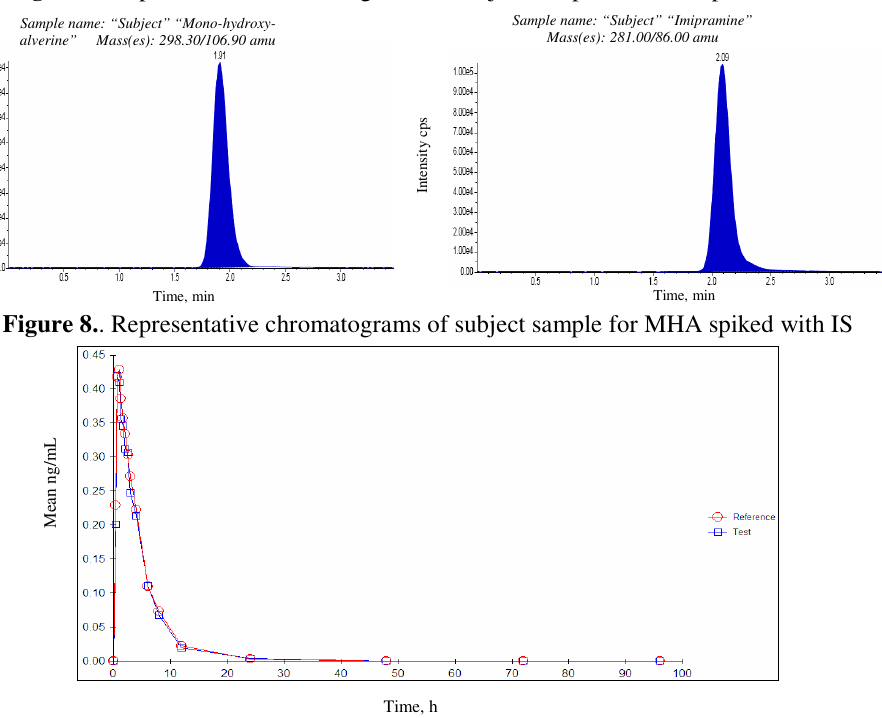
Figure 9. Mean plasma drug concentration –time profile for ALV in healthy volunteers after a single oral dose of 60 mg ALV capsule ( n =